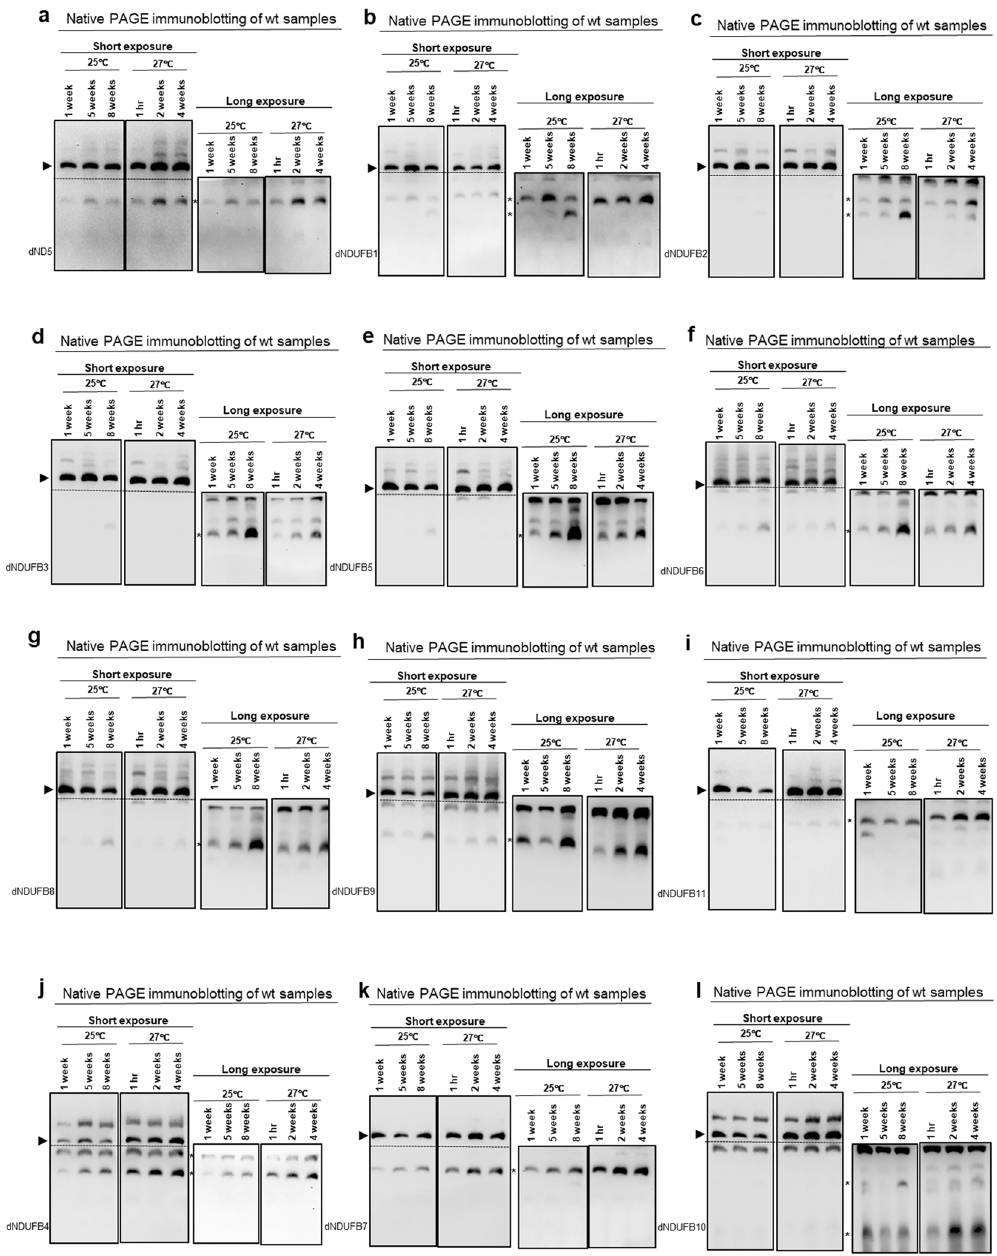
Figure 4. Multiple P D -module subcomplexes accumulate during muscle aging. ( a – l ) Mitochondrial preparations from thoraces of wt flies at the time points and temperatures indicated were analyzed by BN-PAGE, followed by immunoblotting. The antibodies used for the immunoblots were anti-dND5 ( a ), anti-dNDUFB1 ( b ), anti-dNDUFB2 ( c ), anti-dNDUFB3 ( d ), anti-dNDUFB5 ( e ), anti-dNDUFB6 ( f ), anti-dNDUFB8 ( g ), anti- dNDUFB9 ( h ), anti-dNDUFB11 ( i ), anti-dNDUFB4 ( j ), anti-dNDUFB7 ( k ) and anti-dNDUFB10 ( l ). See Fig. S6 for replicates and S7 for full-length gels and